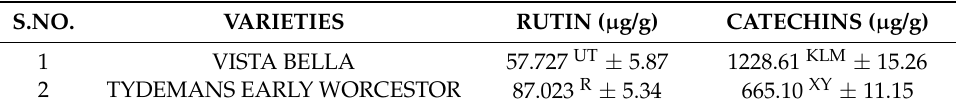
Table 1. Variability in rutin and catchin concentrations in different apple genotypes. The data is represented in mean ± SD ( n = 10) and letter in the superscript symbolize the letters of significance with respect to each other using Tukey’